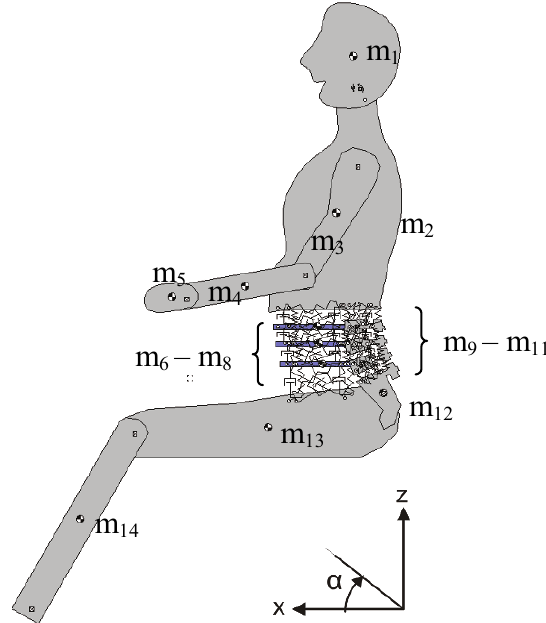
Fig. 3. Biomechanical model of a driver. Figure 3. Biomechanical model of a driver. analysis confirmed the significant impact of biomechanical parameters on vibration of individual human body struc-